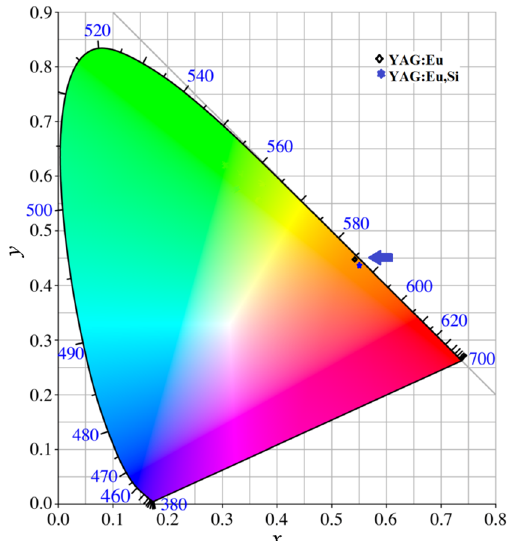
CIE coordinates for YAG:Eu (1 mol%) and YAG:Eu,Si (1 mol%).